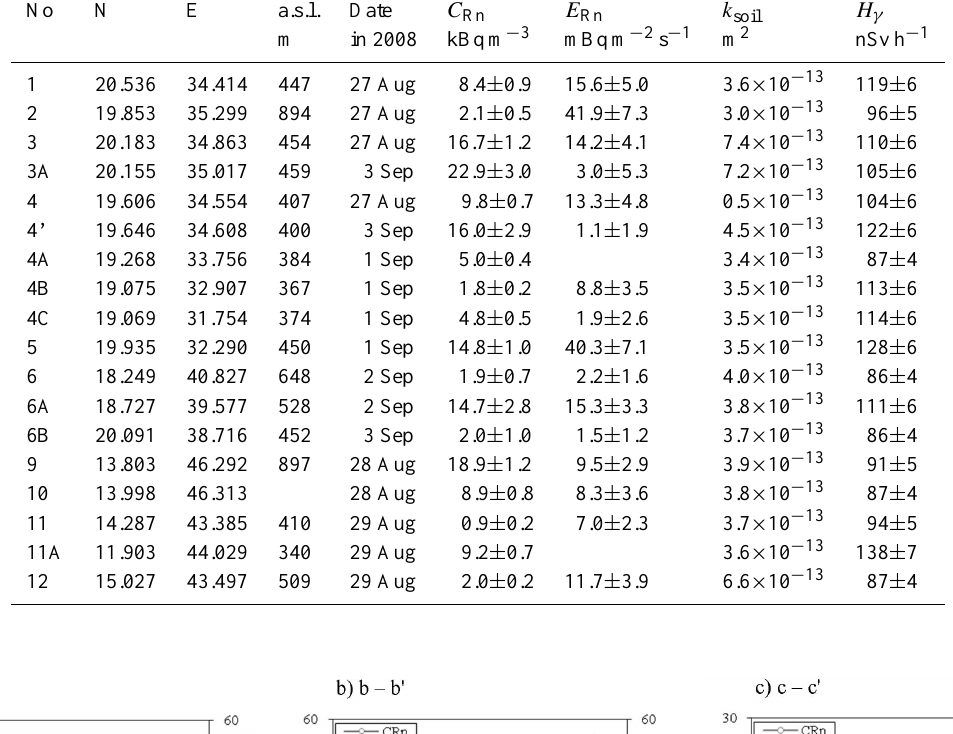
Table 1. Radon activity concentration in soil gas ( C Rn ), radon exhalation rate ( E Rn ), soil permeability ( k soil ) and gamma dose rate ( ˙ H γ ) at the Ravne fault.